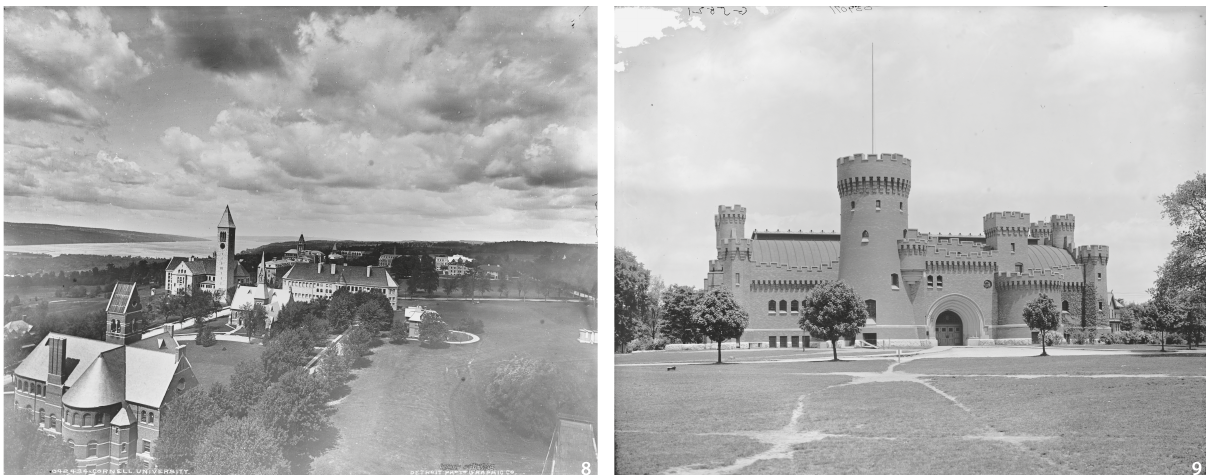
Figure 8 The Arts Quadrangle, circa 1900, Cornell University, Ithaca, New York (Source: US Library of Congress, Washington, DC). Figure 9 The Armory, circa 1900, Ohio State University, Columbus, Ohio (Source: US Library of Congress, Washington, DC).